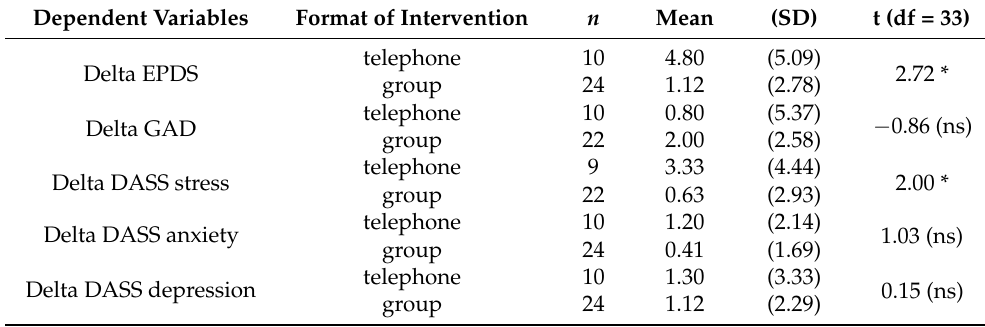
Table 4. Mean delta differences (T1–T2) by intervention type (telephone, group) ( n = 34).